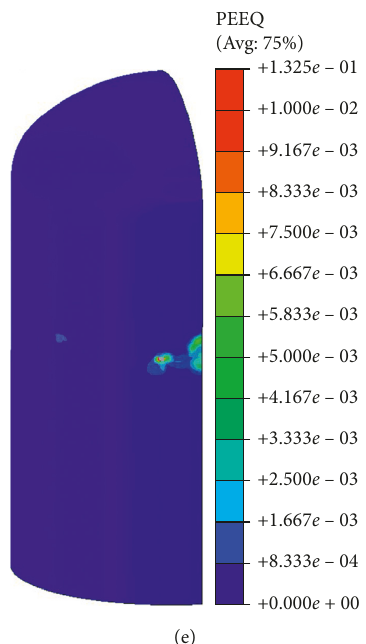
Figure 12: Strain contours of the containment for various element sizes (0.25 s). (a) Case 1. (b) Case 2. (c) Case 3. (d) Case 4. (e) Case 5.